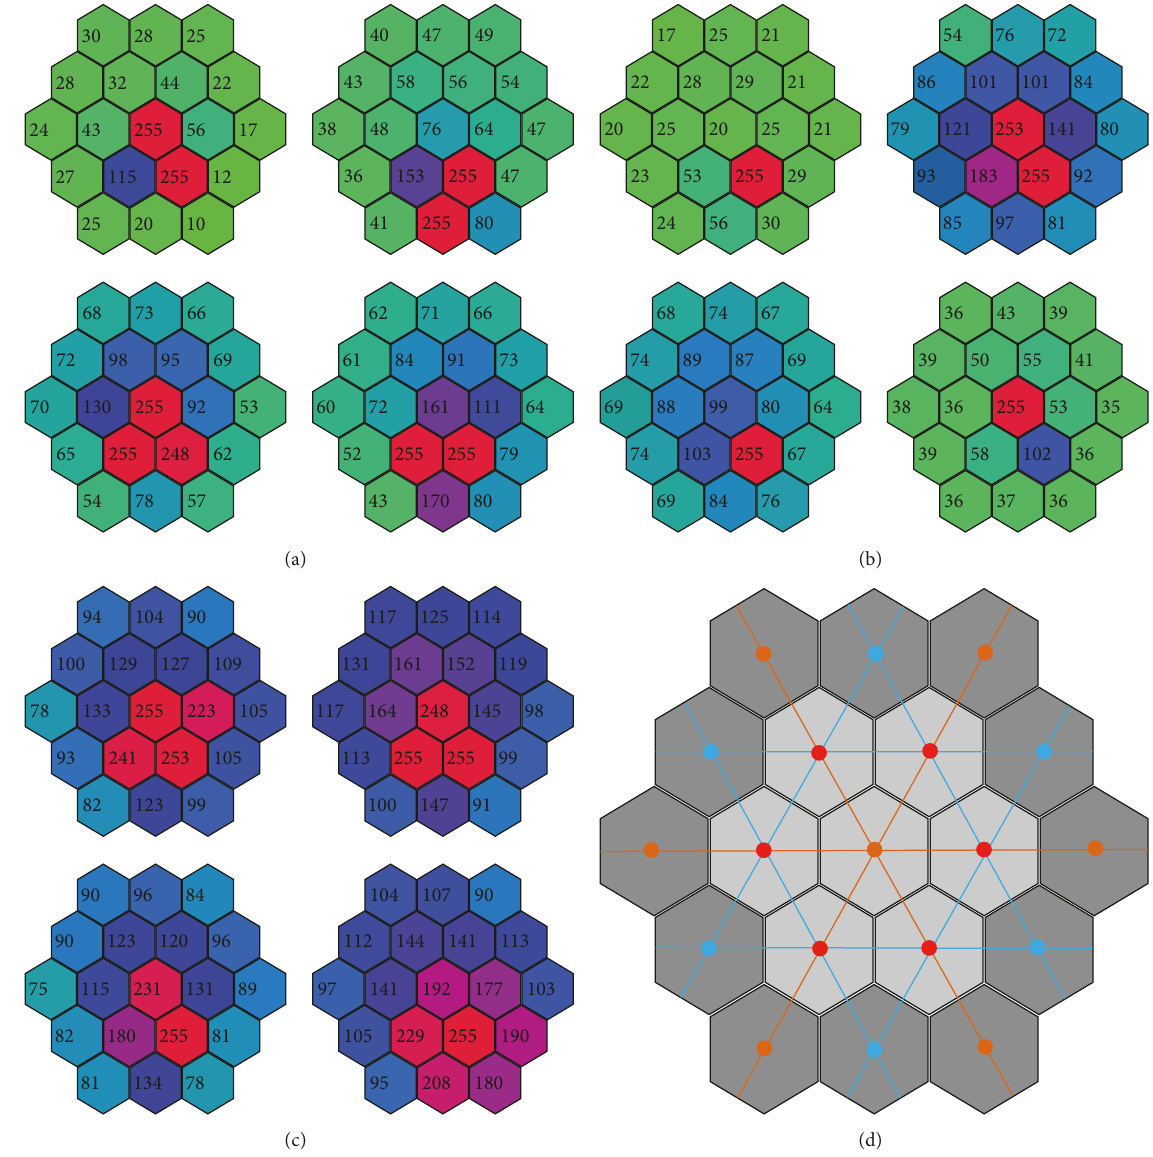
Figure 2: (a–c) Examples of tactile frames for examinations of ST1 (a), ST2 (b), and ST3 (c) type samples. Pressure values are scaled to [0, 255] segment and color-coded. (d) Correspondence between sensors and attributes from the new attribute space. Each hexagon represents one sensor. Middle sensors are colored in light-gray, outer sensors are colored in dark-gray. The main diagonals are shown by orange lines; the secondary diagonals are shown by blue lines. Centers of the hexagons that represent sensors belonging to both main and secondary diagonals are colored in red; belonging only to main diagonals, in orange; belonging only to secondary diagonals, in